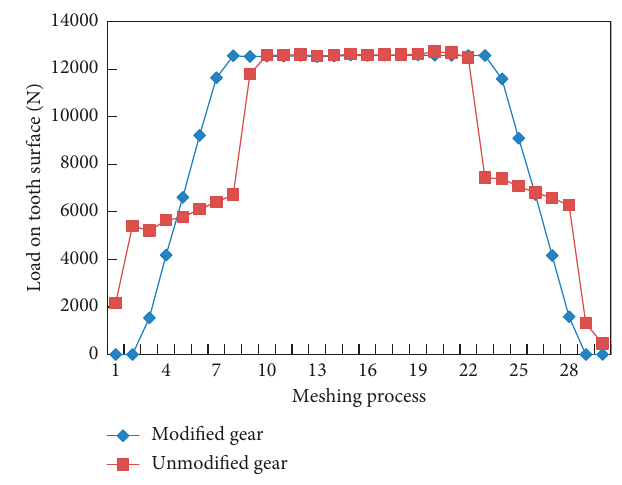
Figure 8: Load on tooth